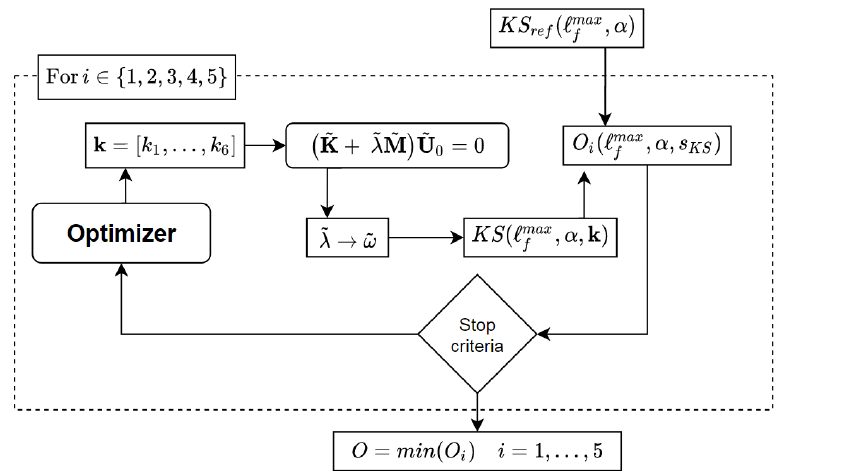
Figure 3. General workflow of the optimization